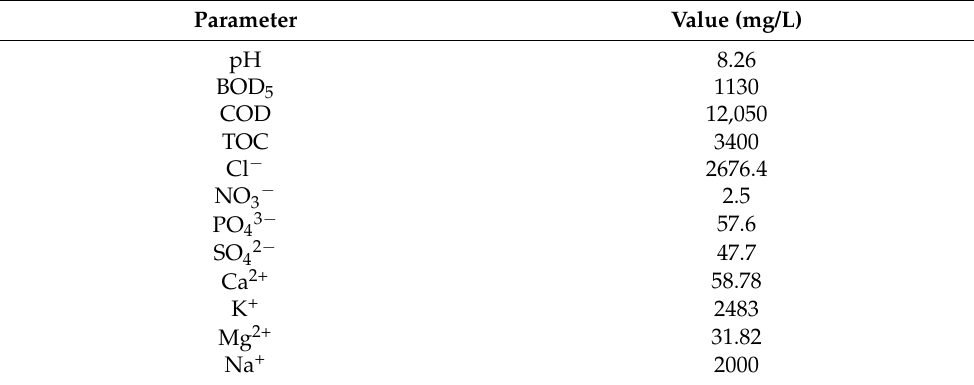
Table 1. Characterization of the untreated